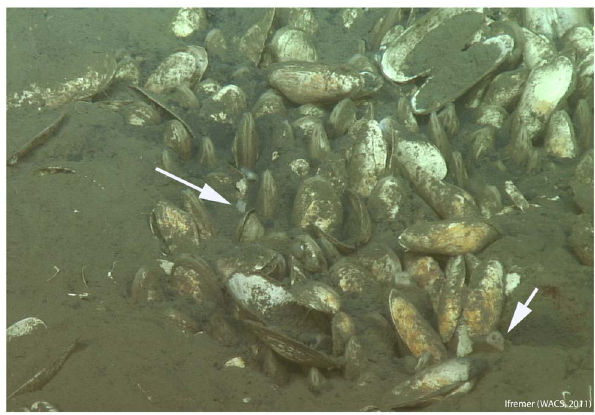
Figure 2. A vesicomyid bivalve bed in Site 3 (see Figure 1), with C.regab and L.chuni . Arrows show L. chuni siphons. Images ROV Victor 6000 , WACS cruise - Ifremer. Reprinted from Ifremer WACS cruise under a CC BY license, with permission from Ifremer, original copyright 2011.